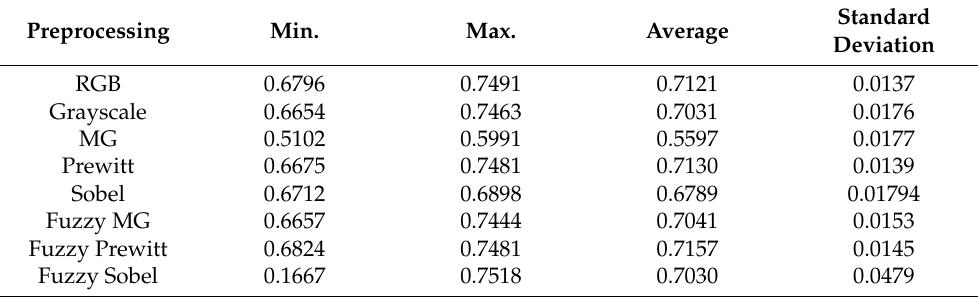
Table 7. Results of the CNN-II model.